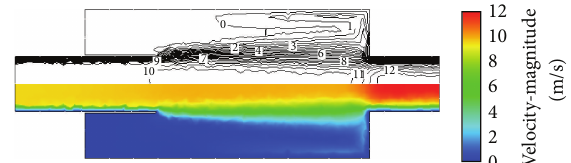
Figure 5: Counters of velocity-magnitude for the expansion cham- ber silencer with inlet flow velocity of V = 10.2 m/s.